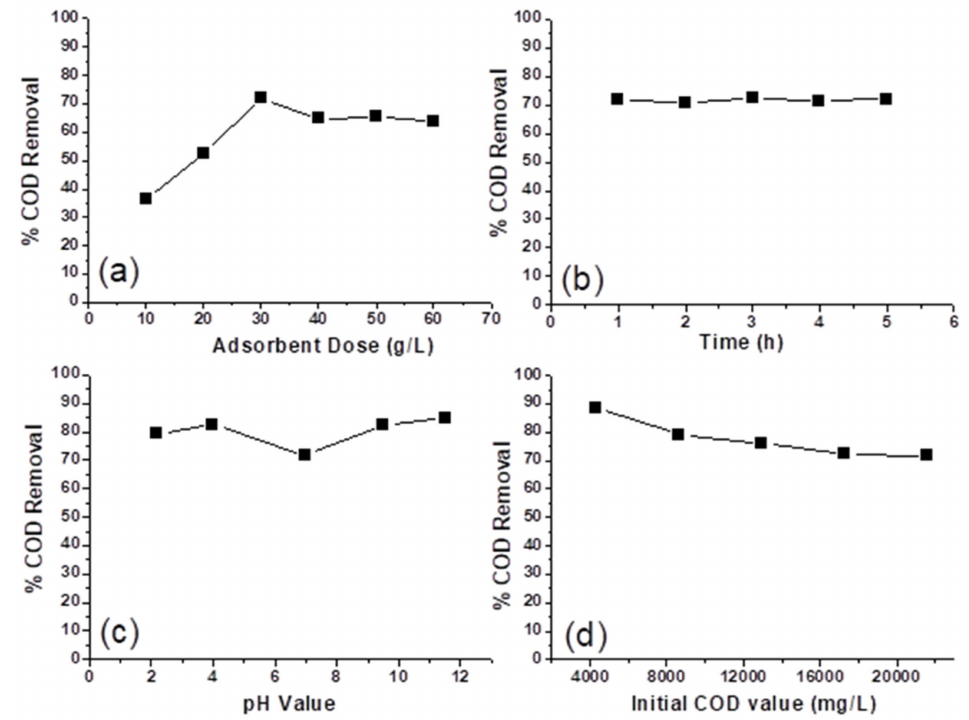
Figure 5. ( a ) Effect of adsorbent dose, ( b ) contact time, ( c ) initial pH value, and ( d ) initial COD value on the % COD removal from PW by sheep dung ash as the